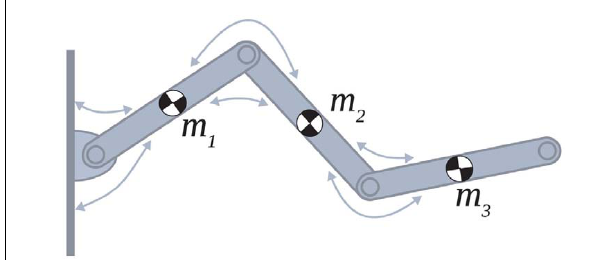
FIGURE 1 | Schematic of the simulated biomechanical limb where each joint is flanked by an opposing pair of muscle actuators (arrows). Each limb segment was modeled as a long, thin, rigid body of length L i and mass m